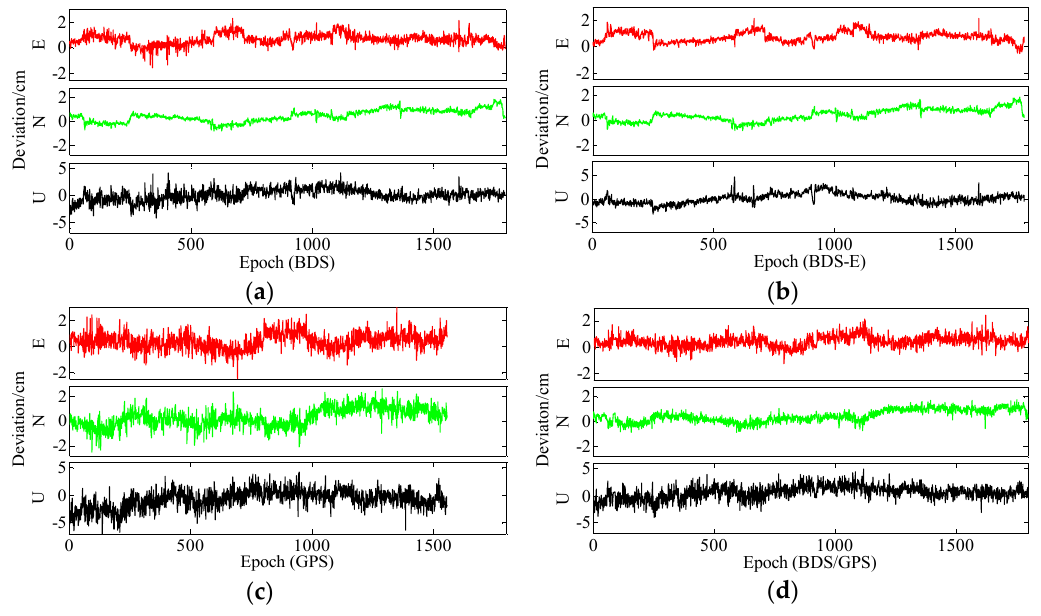
Figure 21. ENU deviations of four systems. ( a ) ENU deviations of BDS. ( b ) ENU deviations of BDS-E. ( c ) ENU deviations of GPS. ( d ) ENU deviations of BDS/GPS.